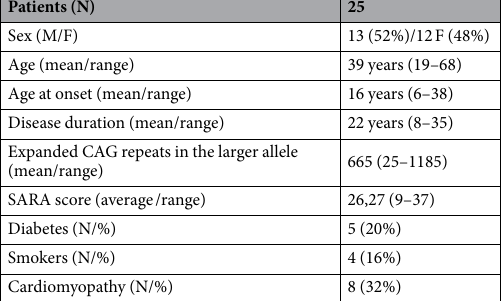
Table 1. Demographic and clinical